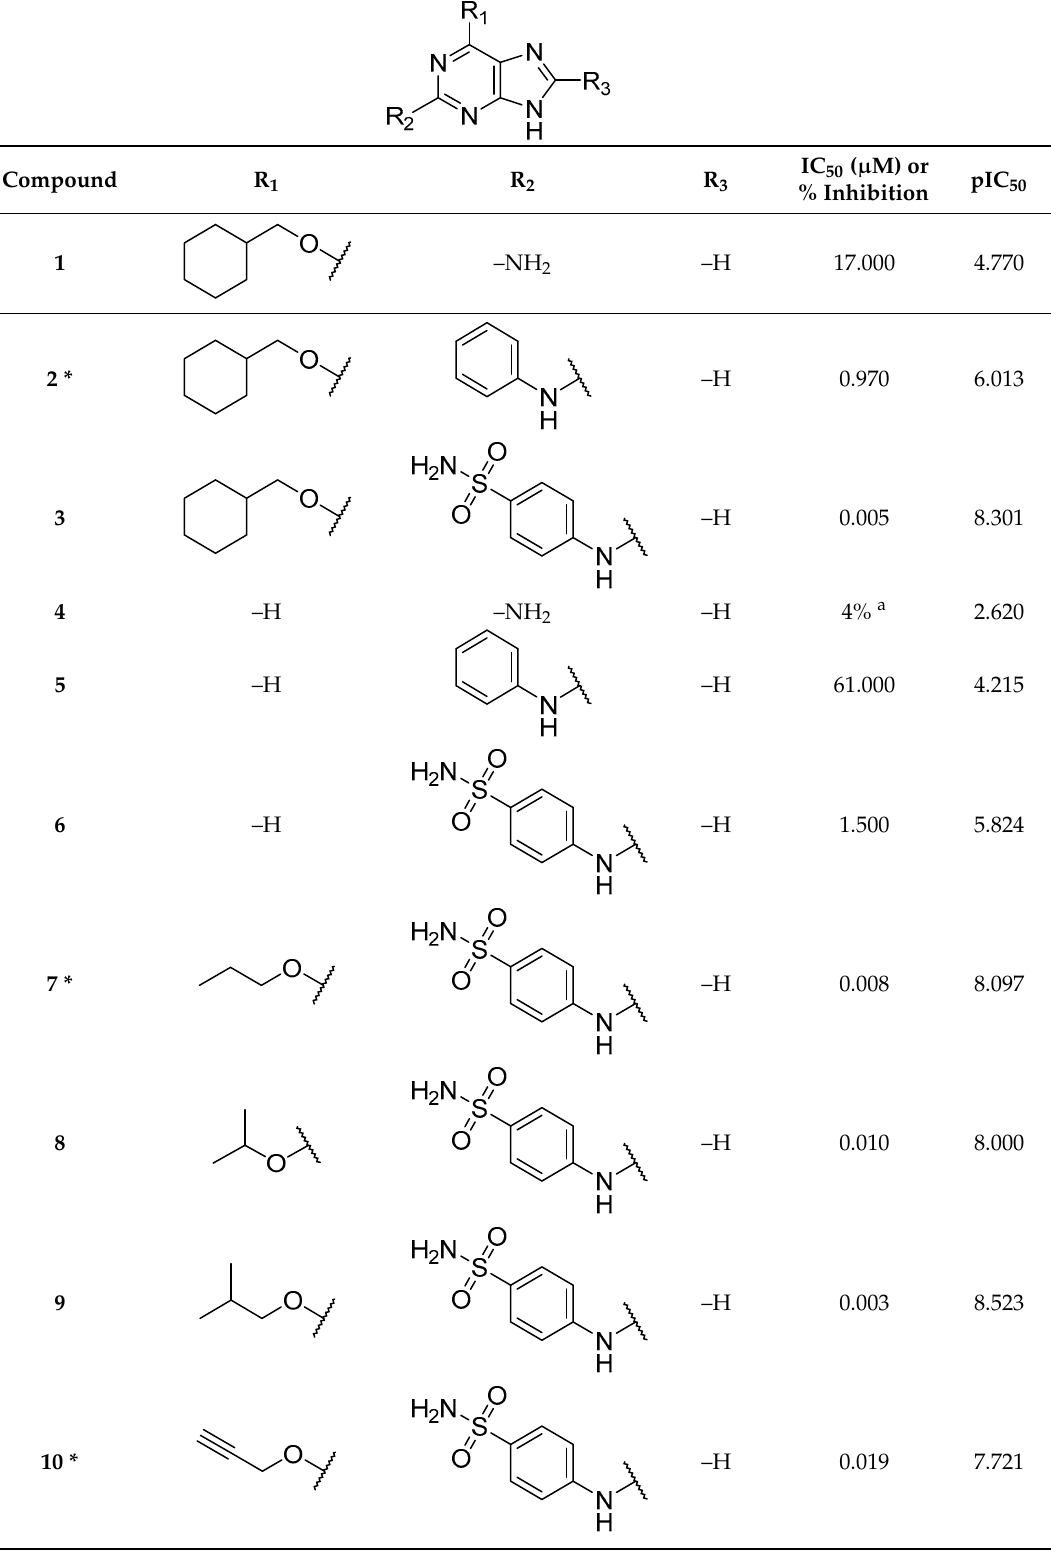
Table 4. The structures and the pIC 50 values of the dataset compounds.